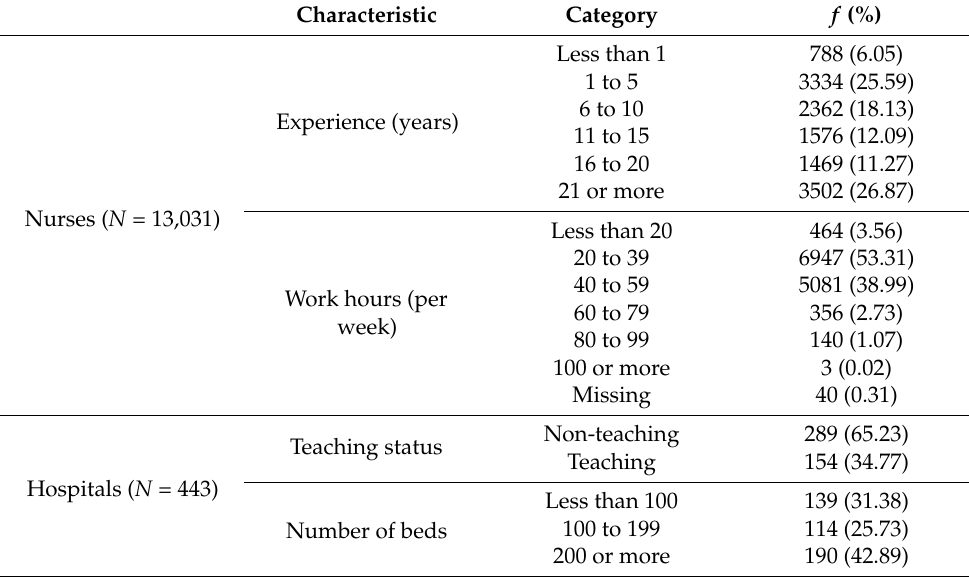
Table 1. Characteristics of nurses and